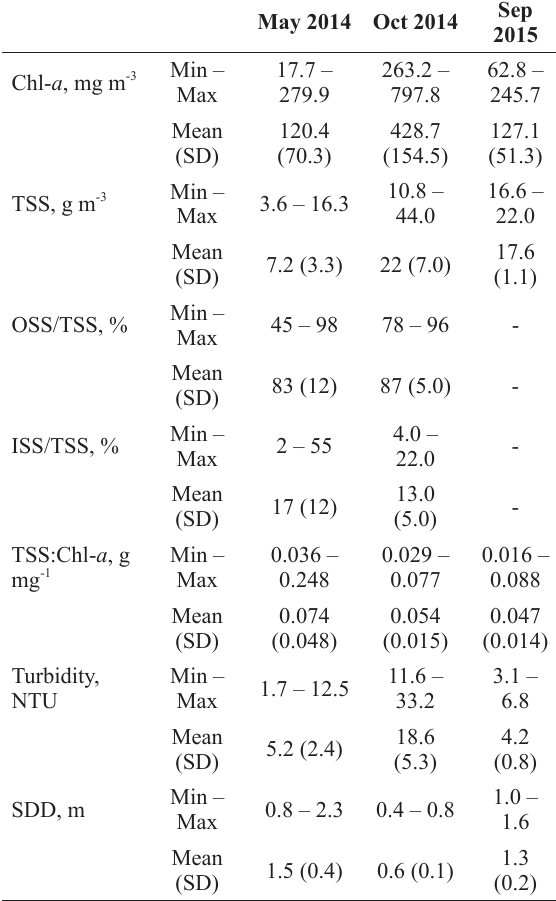
Descriptive statistics of the water quality parameters measured in the field campaigns carried out in May 2014 ( n = 18 samples), October 2014 ( n = 20 samples) and September 2015 ( n = 24 samples). Statistical metrics used were: minimum value (Min), maximum value (Max), mean and standard deviation